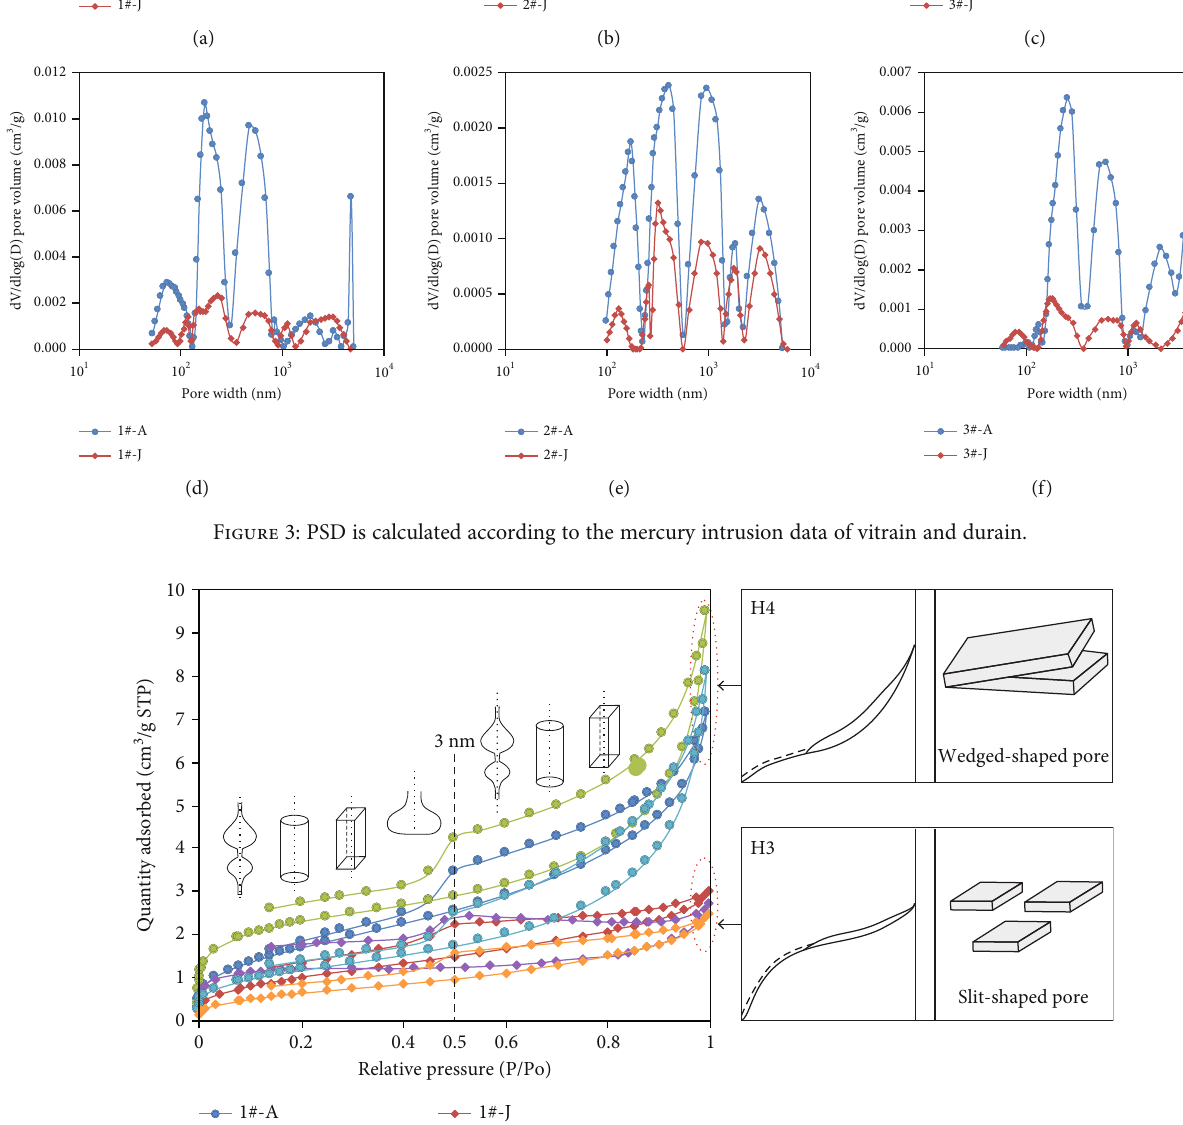
adsorption test of vitrain and 2